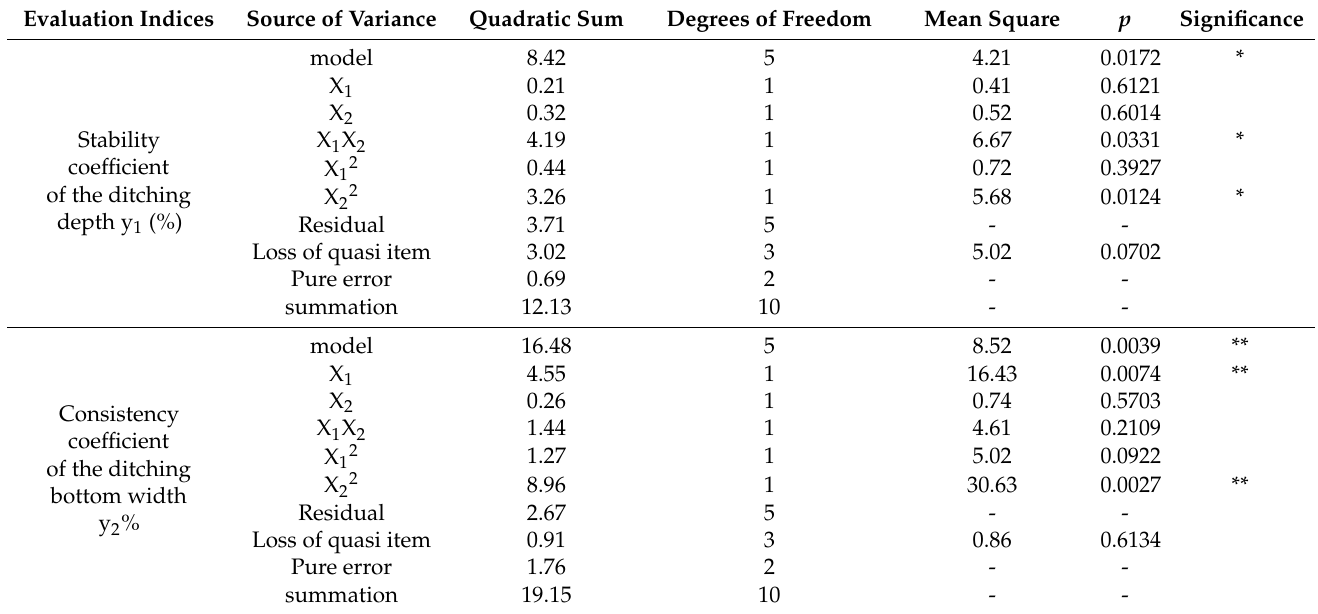
Table 5. Variance analysis of the regression